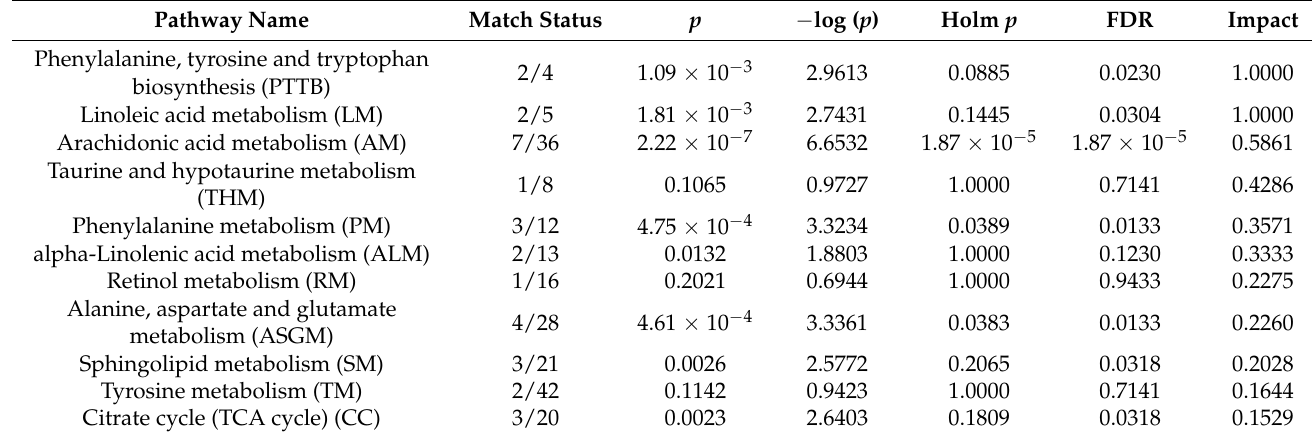
Table 4. The results from metabolic pathways of differential metabolites.